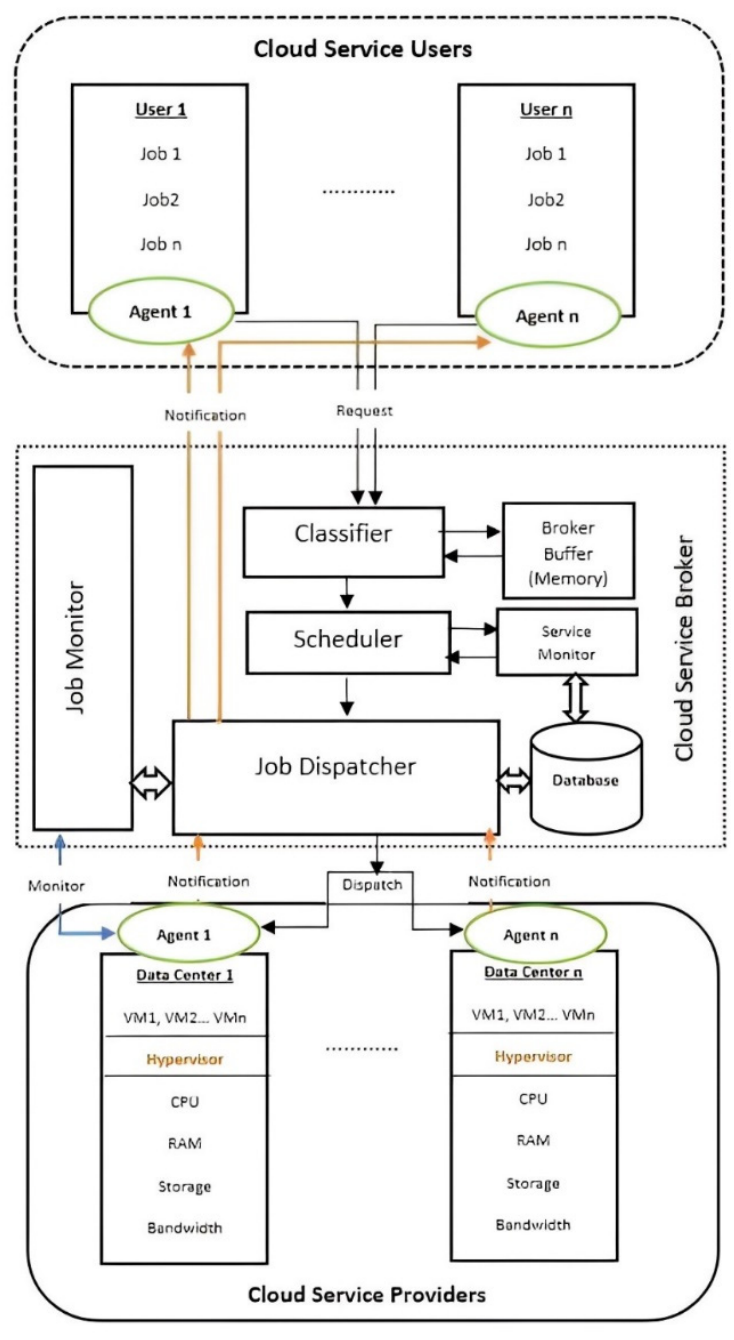
Figure 6. Architecture of Dynamic Congestion Management (DCM) System [44].